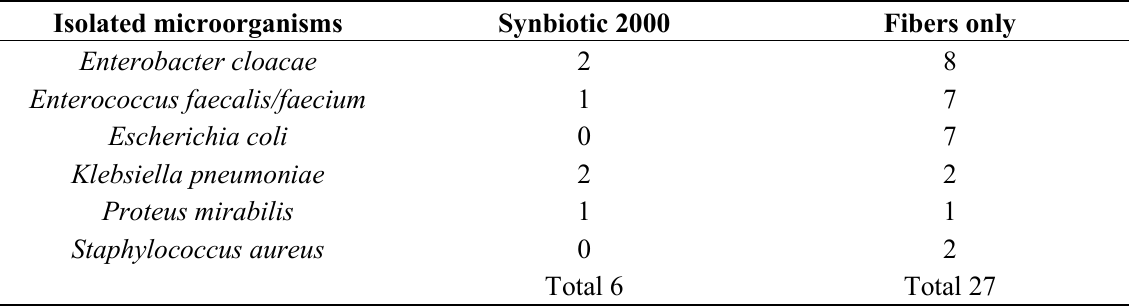
Table 6. Pathogens isolated from patients undergoing pancreatectomy treated with Synbiotic 2000 and only the fibers in Synbiotic 2000, respectively